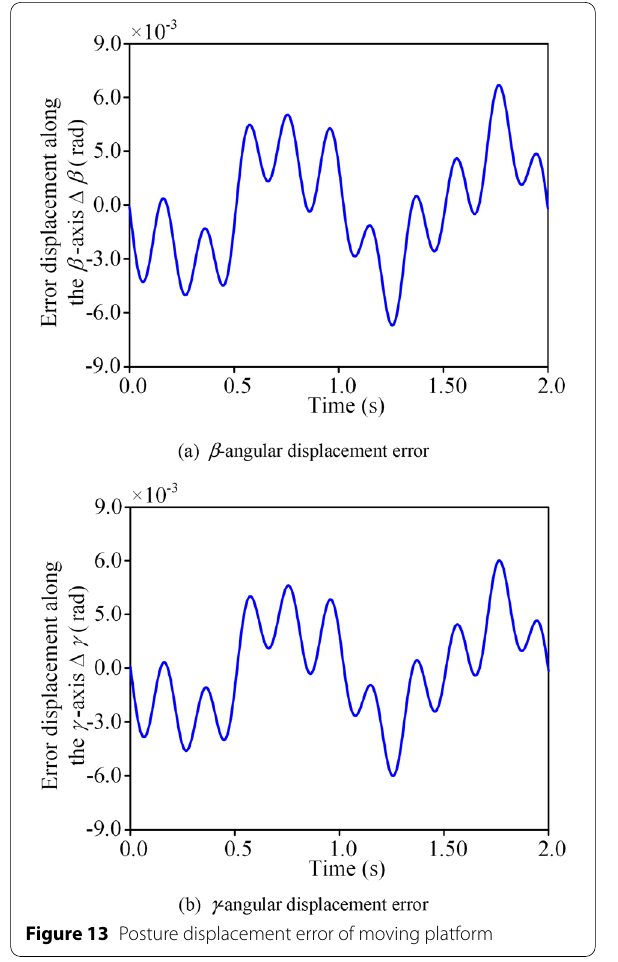
Figure 13 Posture displacement error of moving platform